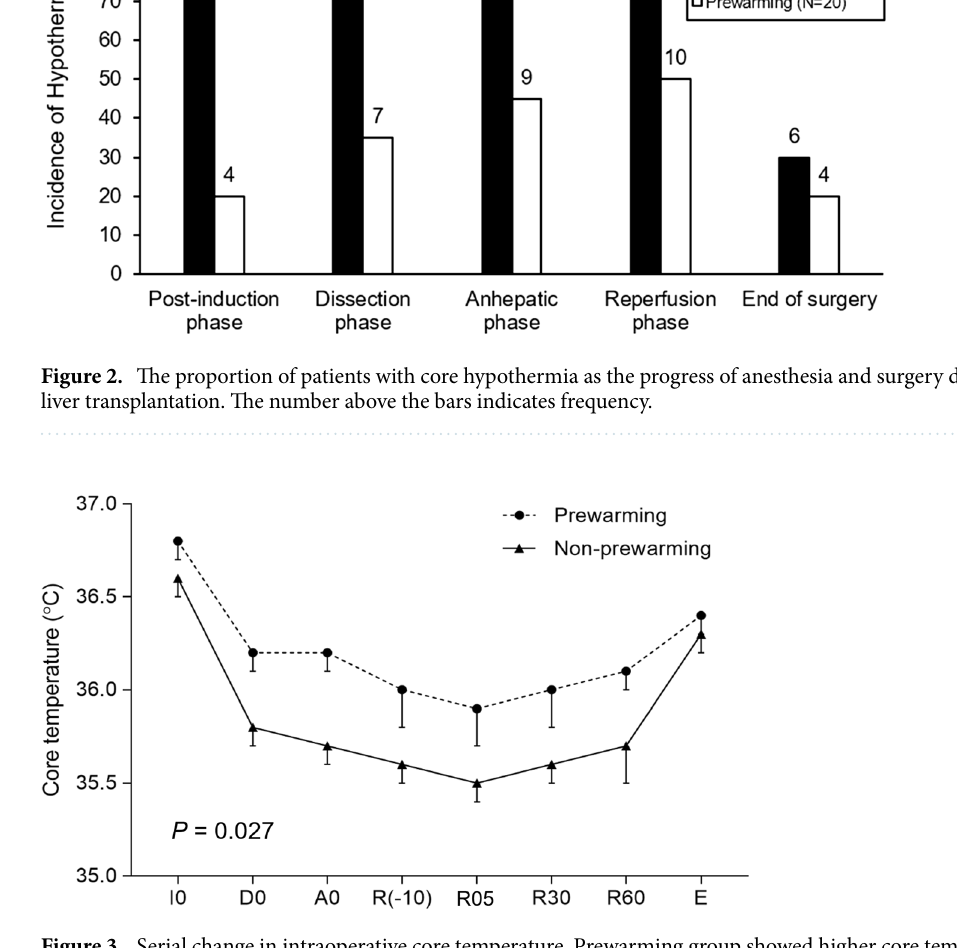
Figure 3. Serial change in intraoperative core temperature. Prewarming group showed higher core temperature at all analyzed times from the start of anesthetic induction to the end of surgery. The start of anesthetic induction [I0], start of dissection phase [D0], start of anhepatic phase [A0], 10 min before graft reperfusion [R(- 10)], 5 min after reperfusion [R05], 30 min after reperfusion [R30], 60 min after reperfusion [R60], and at the end of surgery